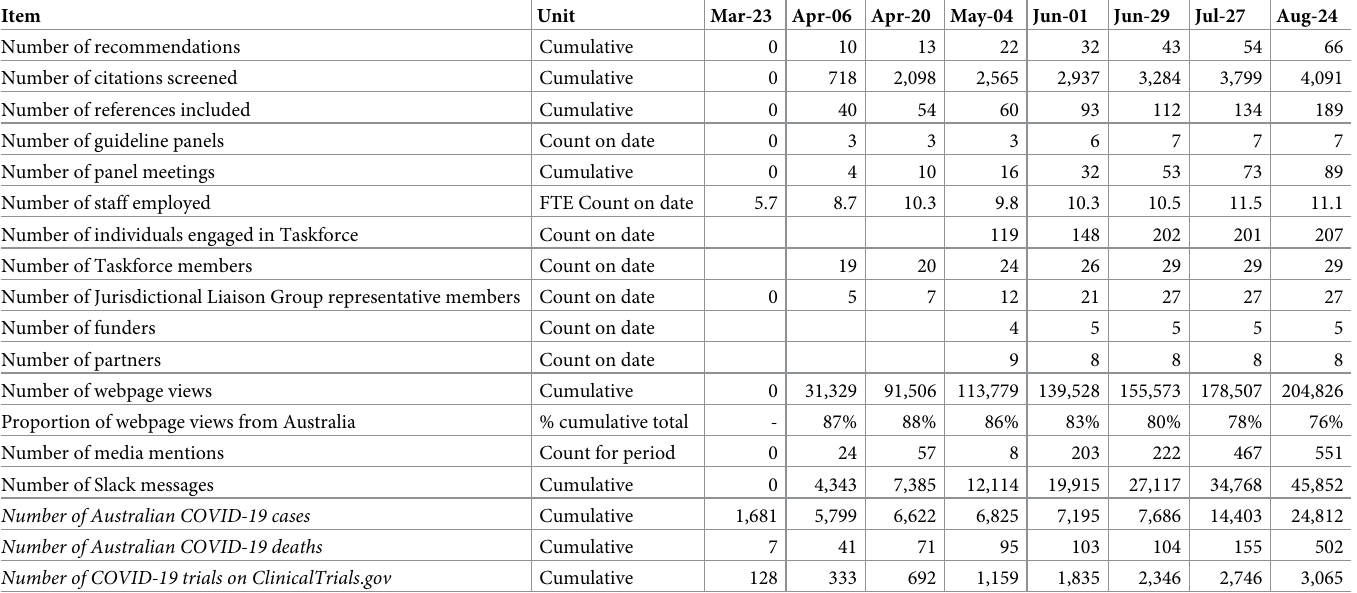
Table 1. Activity stocktake.